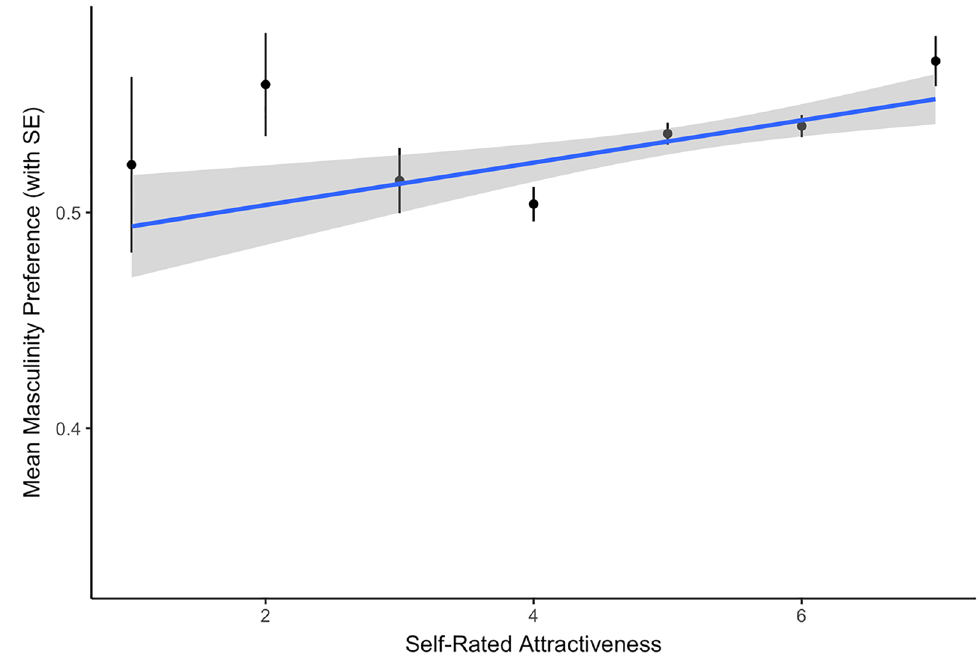
Figure 1. The significant association between self-rated attractiveness and women’s preferences for male facial masculinity.